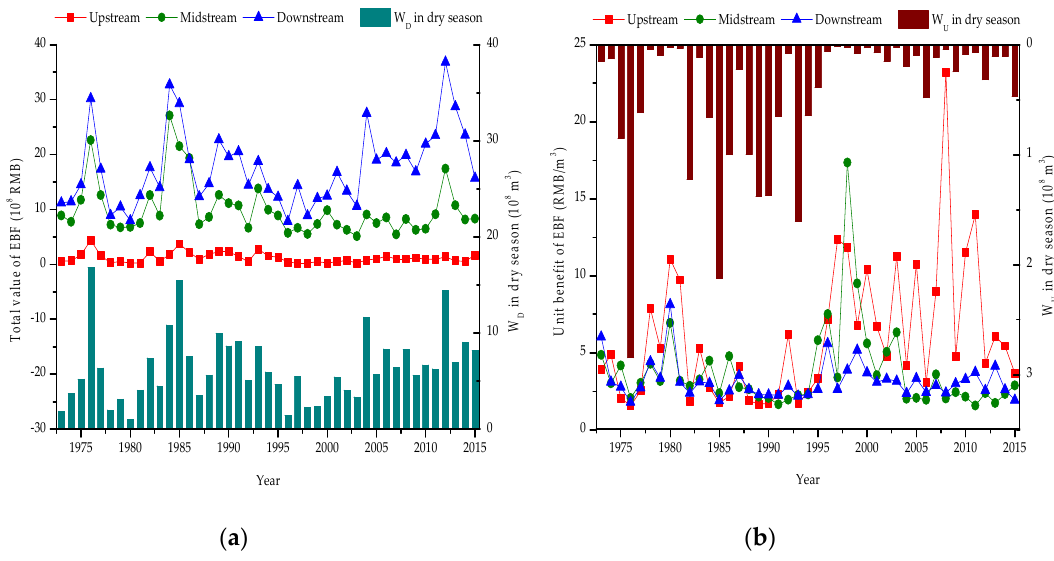
Figure 6. ( a ) The total value of EBF in MSX from 1973 to 2015. ( b ) The unit benefit of EBF in MSX from 1973 to 2015. “ W U ” and “ W D ” represents the water yields of EBF in the upstream and downstream sections in the dry season, respectively.